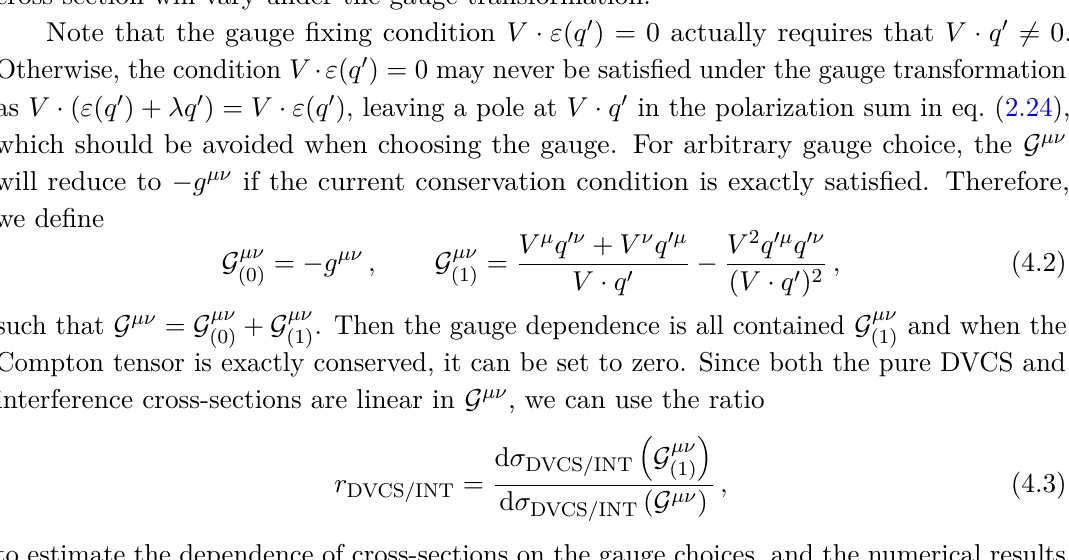
gauge transformation ε µ ( q 0 , Λ 0 ) → ε µ ( q 0 , Λ 0 ) + λq 0 µ . In this subsection, we study how